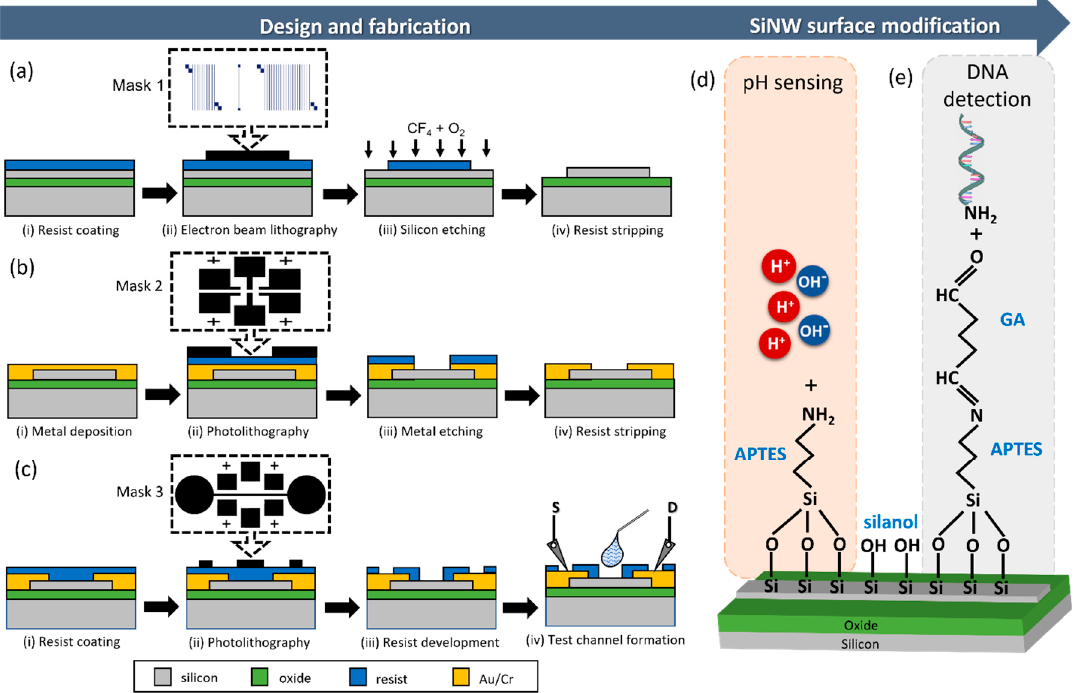
Figure 1. A schematic diagram of top-down fabricated SiNW sensors using EBL mixed photolithography-based CMOS processes with ( a ) Mask 1 for nanowire pattering, ( b ) Mask 2 for fabricating electrode pads, and ( c ) Mask 3 for developing the test channel. ( d ) Chemically modified SiNW using APTES for pH sensing. ( e ) Further surface modification using glutaraldehyde to form GA/APTES/SiNW for amine-terminated ssDNA probe immobilization.